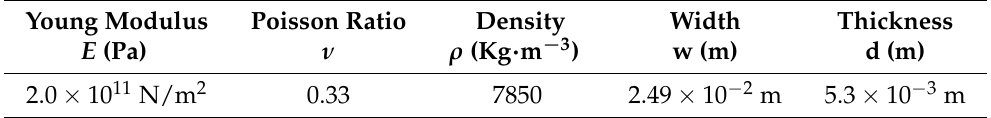
Table 1. The physical parameters of the beam structure.